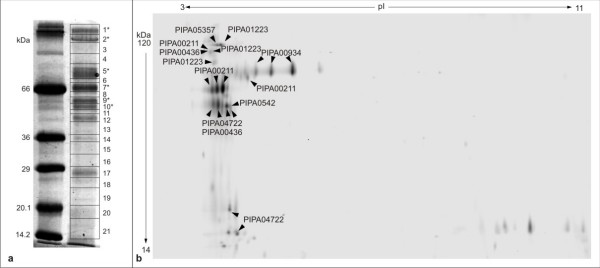
Secretome of P. pastoris. (a) SDS-polyacrylamide gel. Left lane: molecular weight marker, right lane: supernatant of P. pastoris chemostat culture. Boxes indicate the gel slices used for LC-MS protein identification. Bands corresponding to glycoproteins are marked with an asterisk. (b) 2D electrophoresis gel of P. pastoris culture supernatants. Proteins identified by LC-MS are indicated.